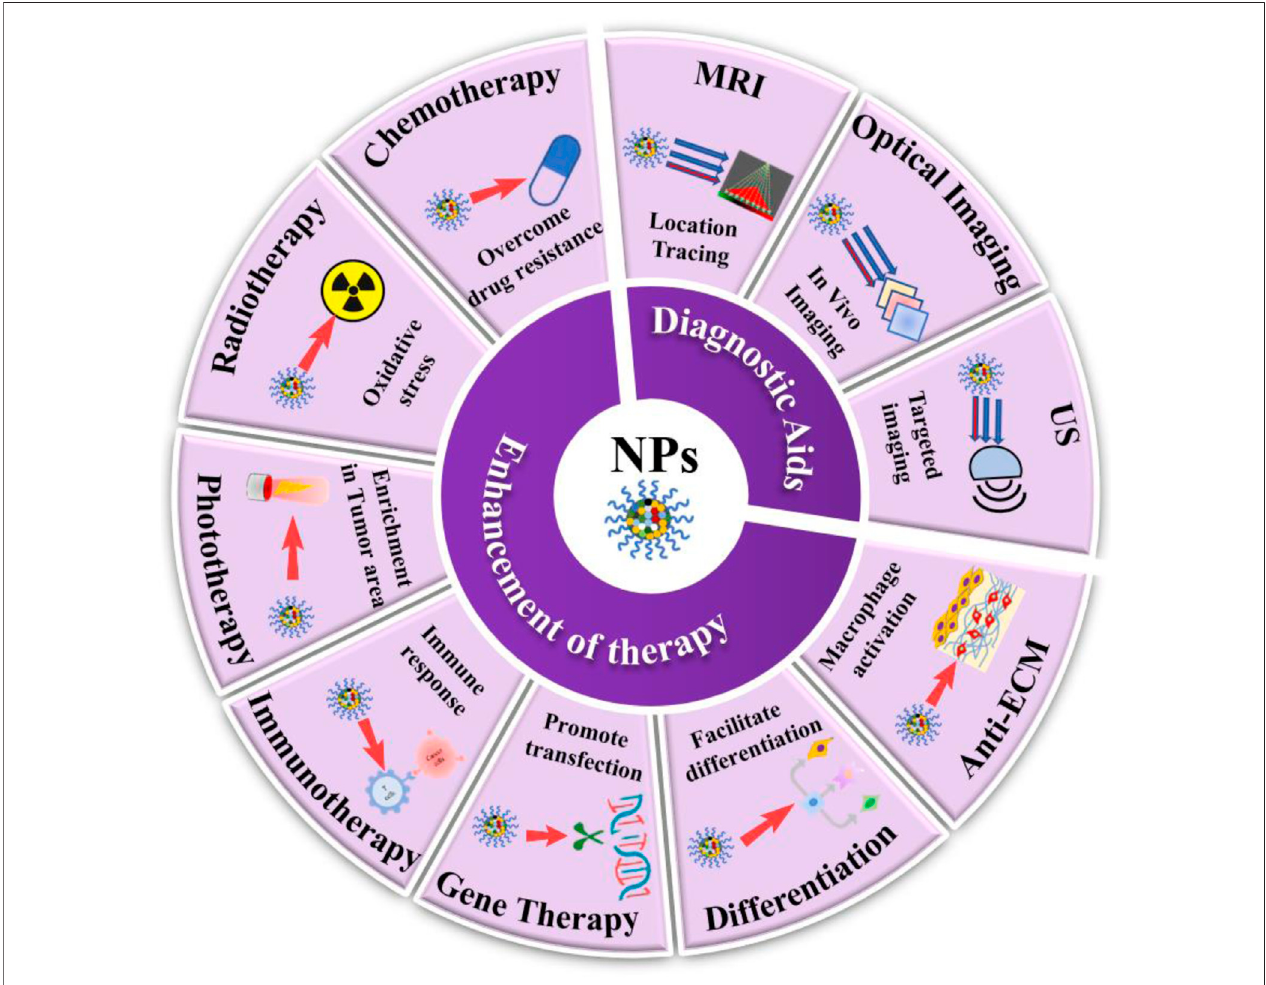
FIGURE 1 | Schematic illustration of emerging nanomedicines for NB diagnosis (MRI, optical. imaging and US) and therapies (chemotherapy, radiotherapy, phototherapy, immunotherapy, gene therapy, differentiation, and anti-ECM therapy).